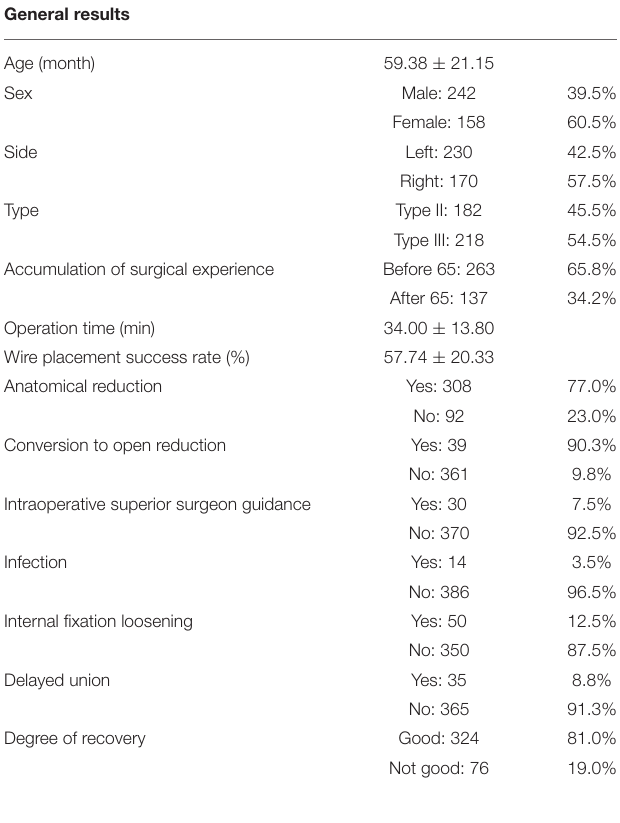
TABLE 1 | Medical and admission characteristics of 400 eligible patient of supracondylar fractures before surgery and subsequent complications. General results